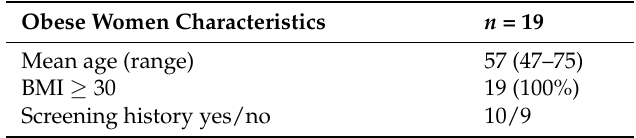
Table 1. Demographic characteristics of obese women and